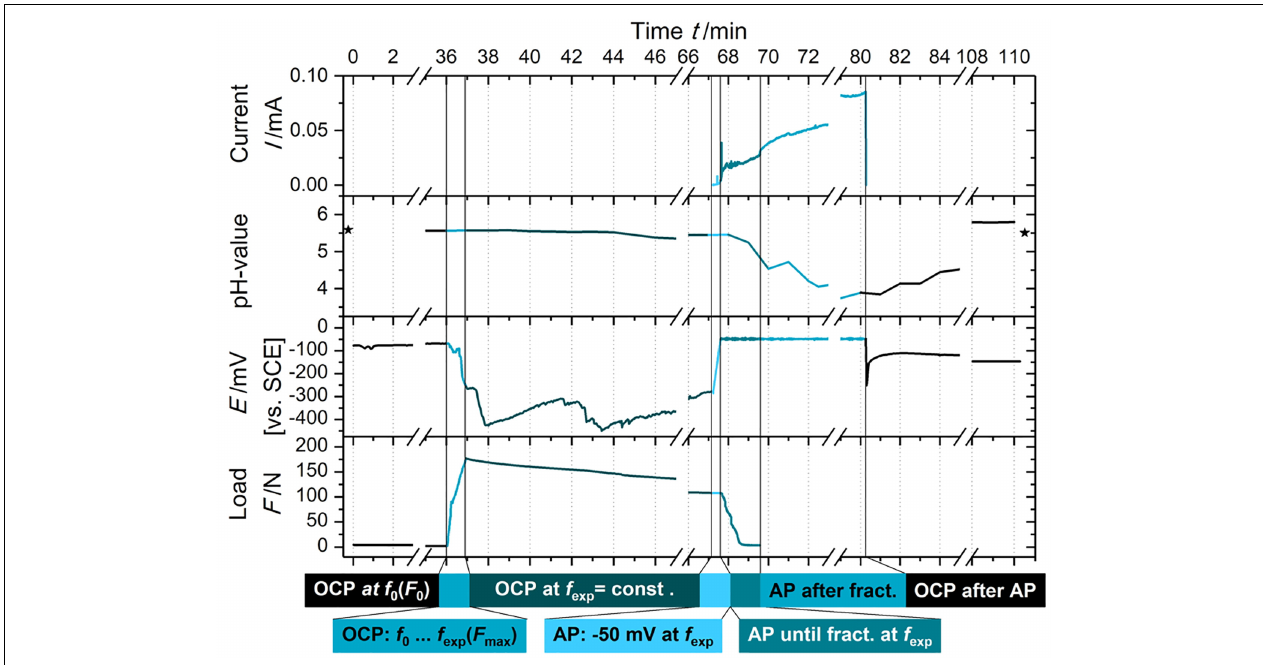
FIGURE 13 | Stress corrosion cracking (SCC) test with a straight-through edge notched Vit 105 three-point-bending (3PB) specimen (type B) in 0.01 M NaCl solution: evolution of load, electrode potential, current, and pH value in dependence of exposure time (Geissler et al., 2019, open-access article with Elsevier user license CC BY